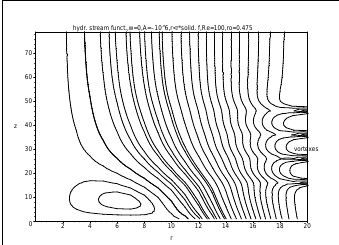
Figure 6. Streamlines of velocity in a pipe with the ring input, Re = 100 ,A = 0 .